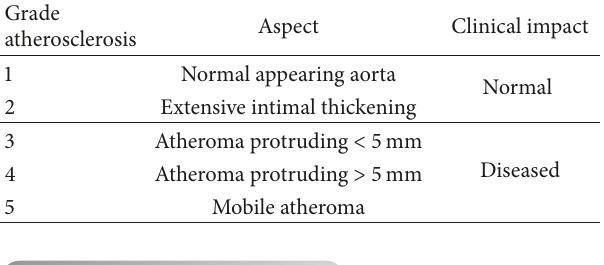
Table 1: Katz’ classification of aortic atherosclerosis.